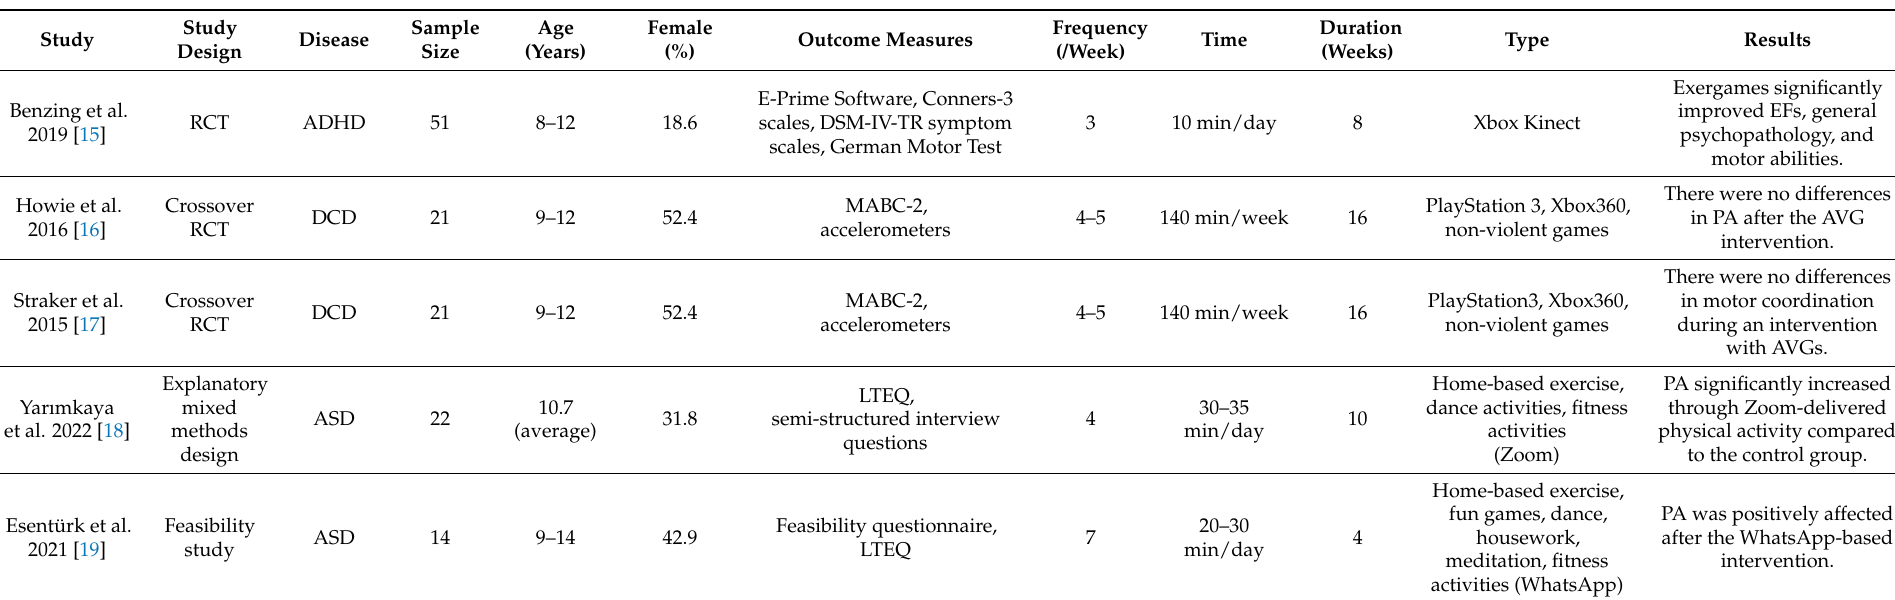
Table 1. Summary of